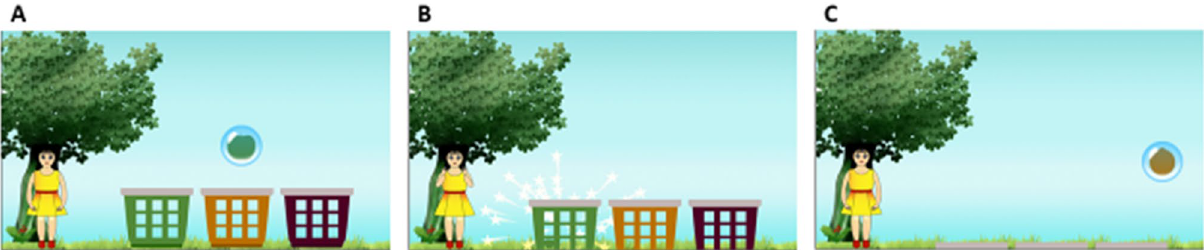
Figure 1. Basket game gameplay. ( A ) A colored fruit is trapped inside a bubble, which moves in a zigzag path above the differently colored baskets. ( B ) The fruit falls in one of the baskets when the player bursts the bubble by tapping it. If the color of the fruit matches the color of the basket, a visual reinforcement is provided: the girl on the left claps and laughs, and a particle scattering effect is displayed. ( C ) As the game progresses, the baskets move down (and out of the screen) gradually such that eventually the colored parts of the baskets are completely hidden.